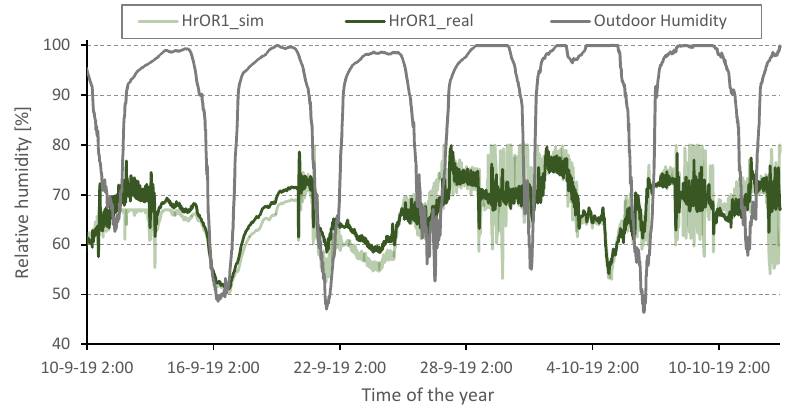
Figure 11. Comparison between measurements and simulation results for air temperature in OR1 during the second experimental campaign.